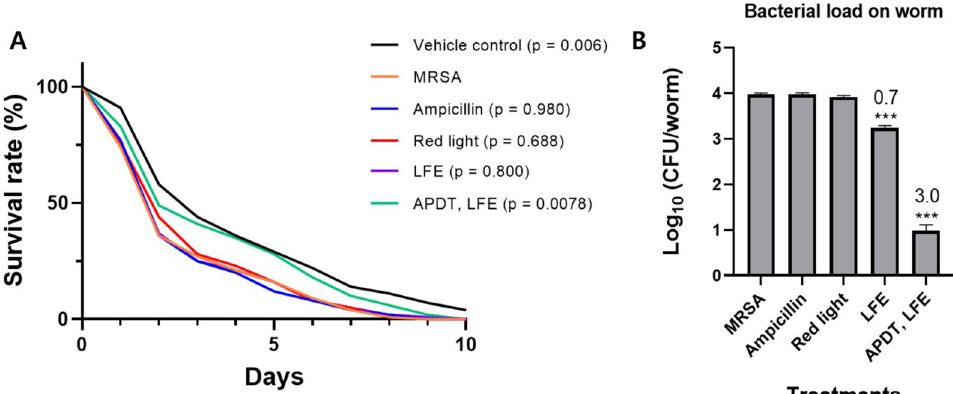
Fig. 7 Effects of APDT efficacy on lifespan A and bacterial attachment B in MRSA‑infected C. elegans . Adult worms were incubated with fresh MRSA suspension for 24 h. Then, LFE (20 µg/mL) was treated for 30 min. DMSO was used as the control group. Next, the worms were allowed to crawl to blank NGM agar twice before the irradiation to red light at 600 W/m 2 for 5 min. The worms were then assessed for survival rate every day ( A ). The p‑value according to the MRSA single treatment is presented. The data are representative of three independent experiments. Five worms from each treatment plate were also moved to fresh LB broth and spread onto LB agar for CFU determination of viable bacteria associated with C. elegans ( B ). The data are reported as mean standard error of duplicates and representative of three independent experiments. ns indicates no statistical ± significance relative to MRSA; significant differences are expressed with *** for p < 0.001 relative to MRSA. The log reductions compared with MRSA are presented in each